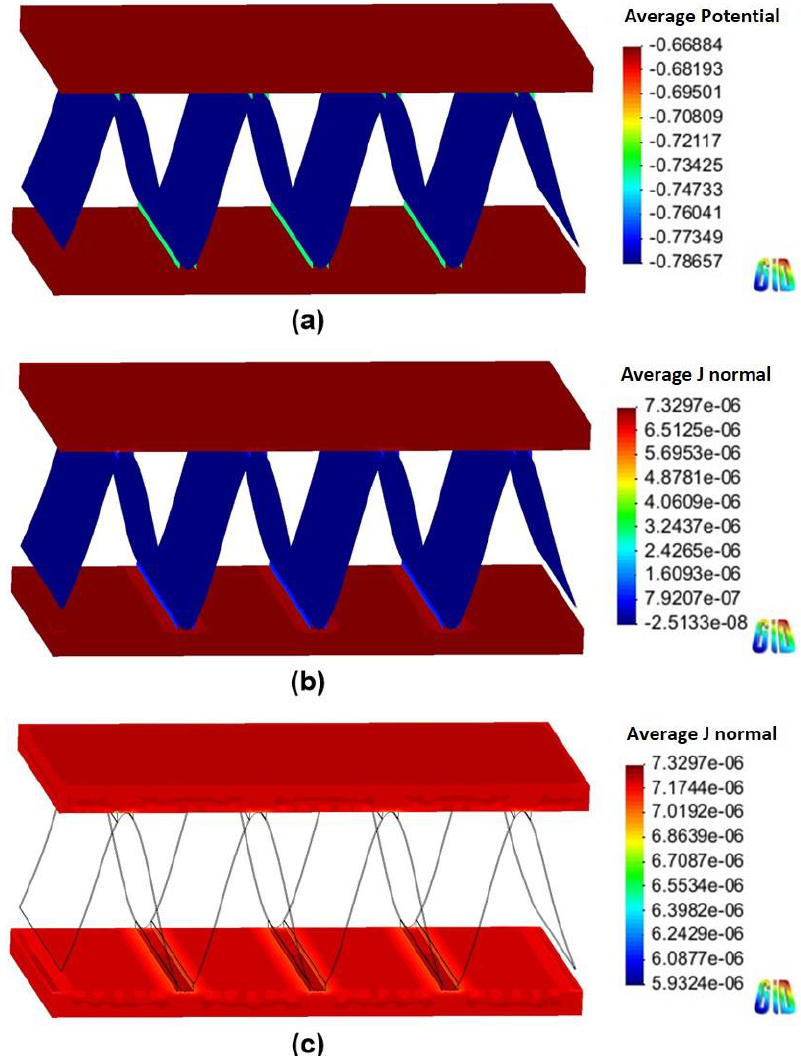
Figure 9. Simulation results of the Al fin-tube heat exchanger assembled with an anodic joint in low-conductivity electrolyte: ( a ) potential distribution, ( b ) current density distribution, and ( c ) current density distribution at the tube.